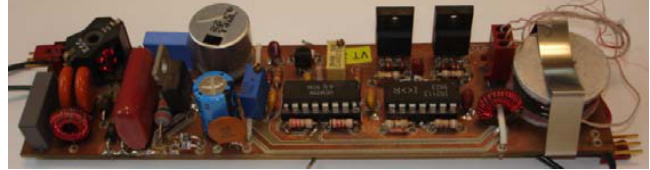
Figure 16. Inductor-less Piezoelectric Transformer-based Linear Ballast with Power Factor Correction using a Transoner radial piezoelectric transformer (Courtesy of Micromechatronics).